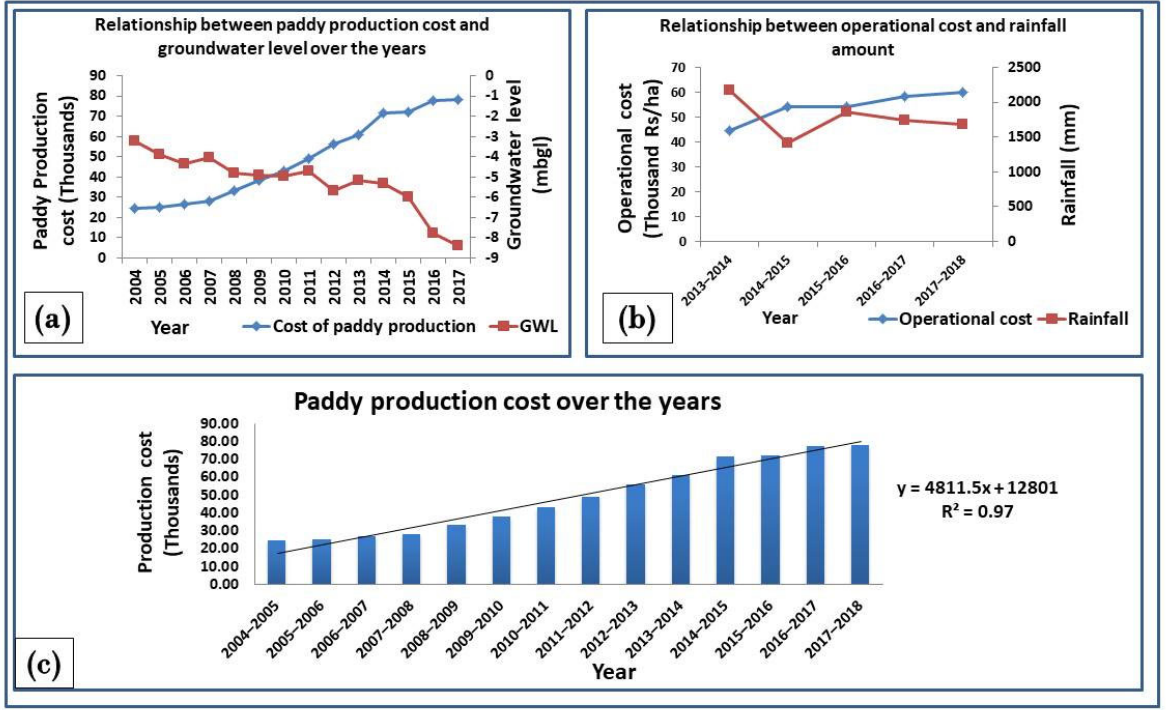
Figure 13. ( a ) Relationship between groundwater level (GWL) and cost of paddy production (2004–2017), ( b ) Relationship between annual rainfall and operational cost of paddy production (2013–2018), ( c ) Overall cost of paddy production over the years.